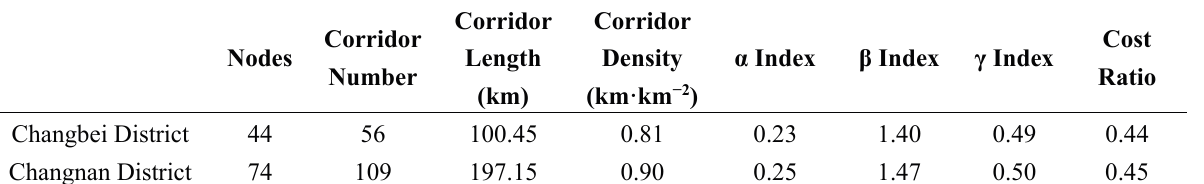
Figure 4. Planning of ecological network for the Nanchang urban area. Table 3. The corridor structure metrics for the ecological network